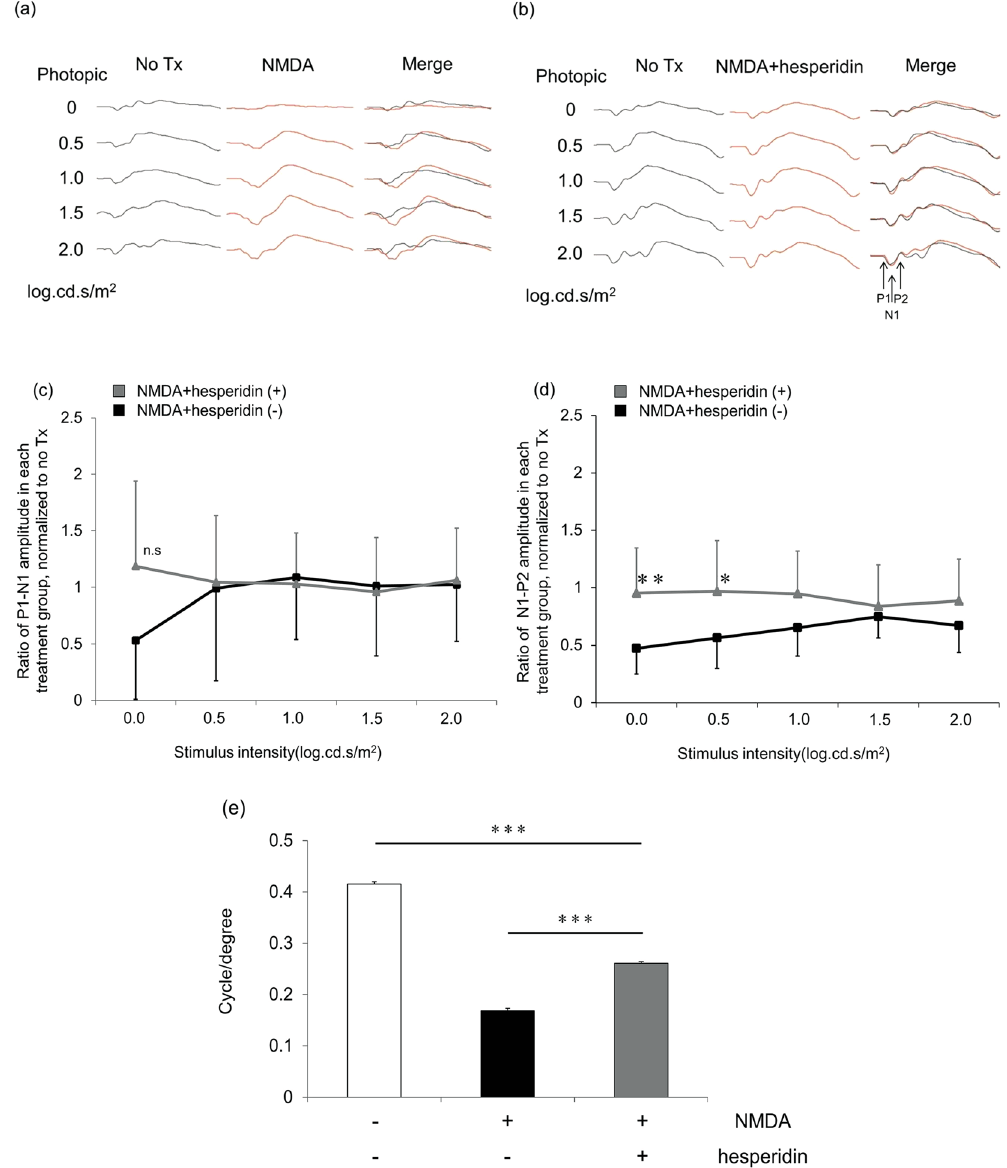
Figure 8. Reductions in visual function after NMDA injury were ameliorated by hesperidin treatment. Representative VEP wave patterns in eyes that were untreated, treated with NMDA, or treated with NMDA and hesperidin ( a , b ). P1: initial positive wave, N1: initial negative wave, P2: second positive wave. Graphs showing the amplitude ratio for the P1N1 ( c ) and N1P2 ( d ) waves after treatment with NMDA or NMDA/hesperidin. No treatment: contralateral left eye, NMDA: right eye after NMDA injury ( n = 10), NMDA/hesperidin: right eye after NMDA and hesperidin injection ( n = 8). Data represent mean ± SD, * p < 0.05, ** p < 0.01. Histogram showing visual acuity ( e ). Visual acuity in the eyes that received NMDA or NMDA/hesperidin injections represents the response to motion in the counterclockwise direction, and visual acuity in the untreated eyes represents the response to motion in the clockwise direction ( n = 5 each). Data represent mean ± SD, *** p <